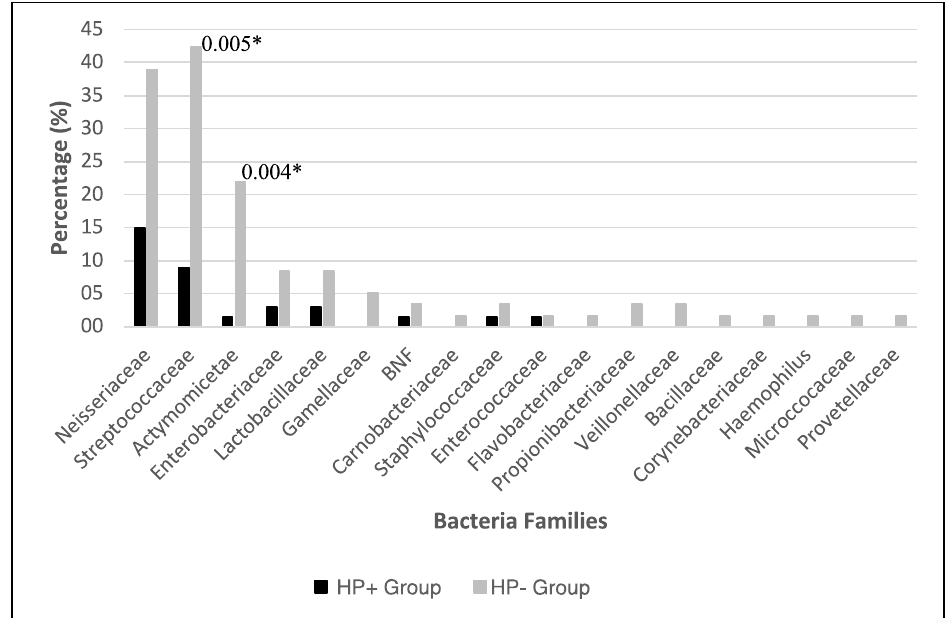
Figure 2. Distribution of cultivable gastric microbiota present in the gastric epithelium. Diversity of cultivable bacterial families isolated from gastric biopsies according to the H. pylori (HP+) and non-pylori species colonization (HP-). (BNF: Gram-negative non-fermenting bacilli). *: Significant statistical differences p < 0.05.